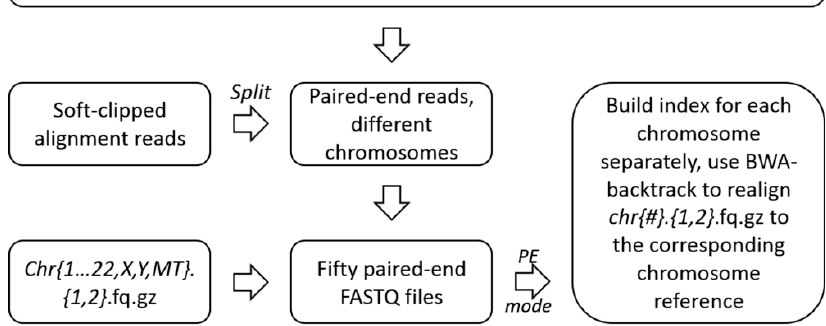
Figure 4. Unscrambling of the soft-clipped alignment reads and realignment.